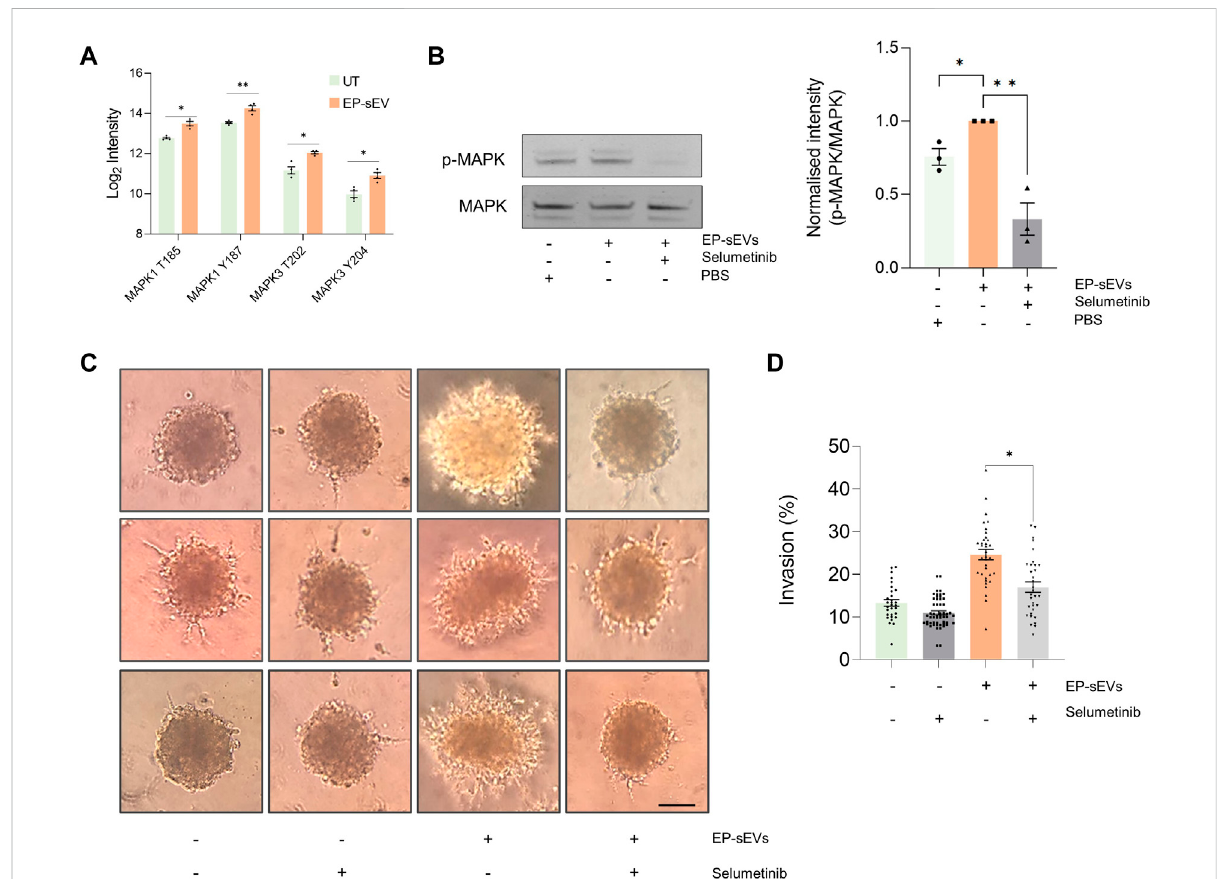
FIGURE 4 Endometrialsmallextracellularvesiclespromotetrophoblastinvasion by activating MAPK pathway. (A) Phosphopeptide-based quanti fi cation of MAPK activation and signaling (mass spectrometry at residue sites MAPK1: T185, Y187, and MAPK3: T202 and T204 in response to EP-sEV treatment based on Student ’ s T. test (* p < .05, ** p < .01). (B) Western blot validation of phosphorylated MAPK (ERK1/2) and total MAPK of hTSCs in presence/absence of EP-sEVs and MEK1/2 inhibitor, selumetinib, based on Student ’ s T. test (* p < .05, ** p < .01). Data presented as mean ± SEM ( n = 3 replicates). (C)